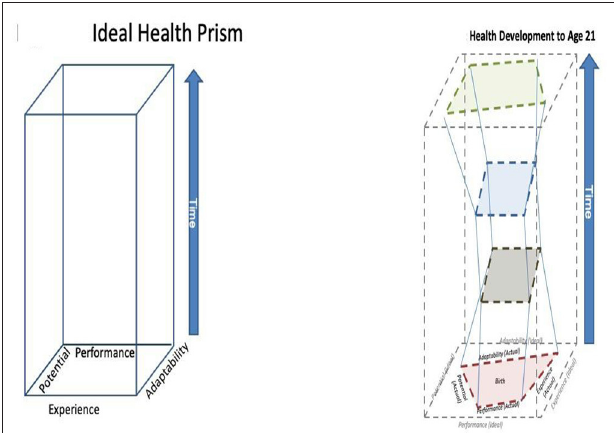
FIGURE 1 | The four dimensions of health measurement form a planar shape that evolves through the dimension of time. If all four dimensions are balanced, the plane can be represented by a square and the temporal trajectory would be a quadrilateral cuboid, shown on the left. A feasible trajectory of an actual person is on the right showing changes in proportions over